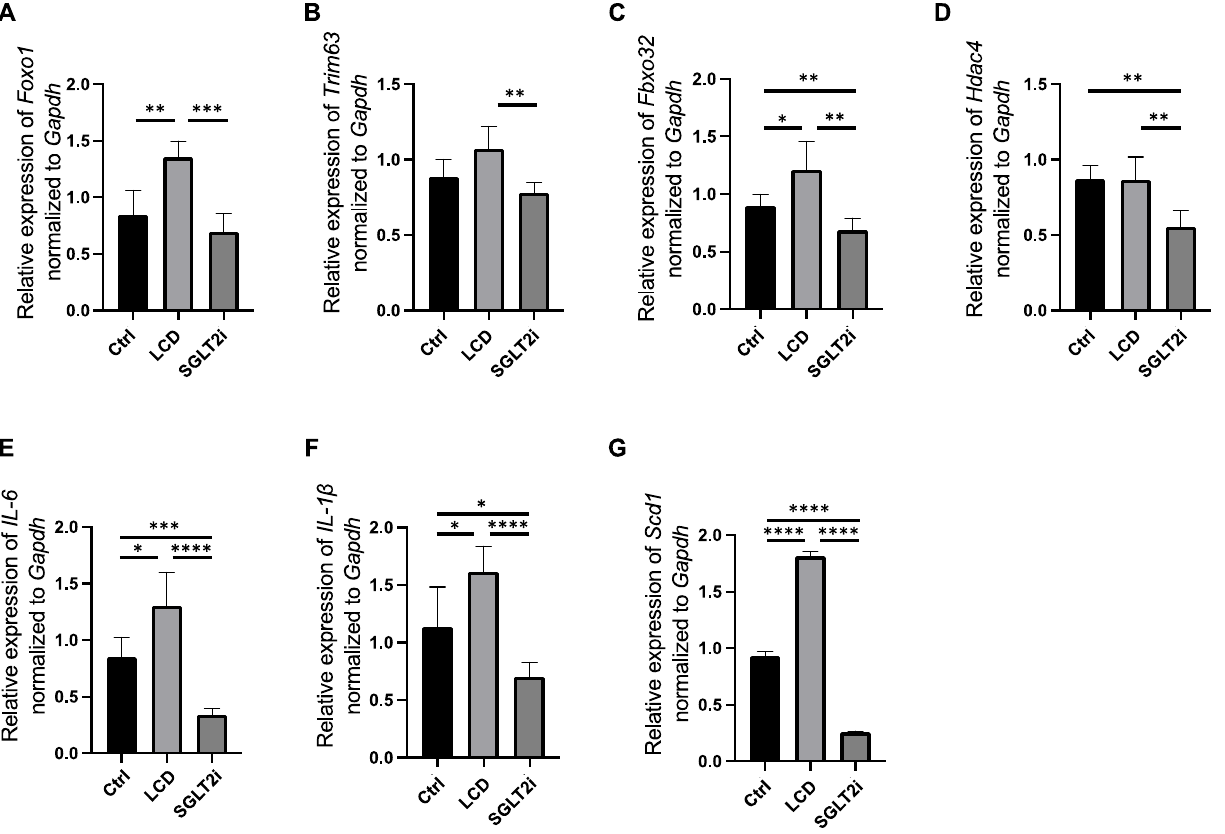
Figure 5. Gene expression in the soleus muscle evaluated using real-time reverse transcription polymerase chain reaction (RT-PCR). The relative expression of ( A ) Foxo1, ( B ) Trim63, ( C ) Fbxo32, ( D ) Hdac4, ( E ) Il6, ( F ) Il-1beta, and ( G ) Scd1 normalized Gapdh. Data are mean ± SD. One-way ANOVA was used for statistical analyses. * p <0.05, ** p < 0.01, *** p <0.001 and **** p < 0.0001.